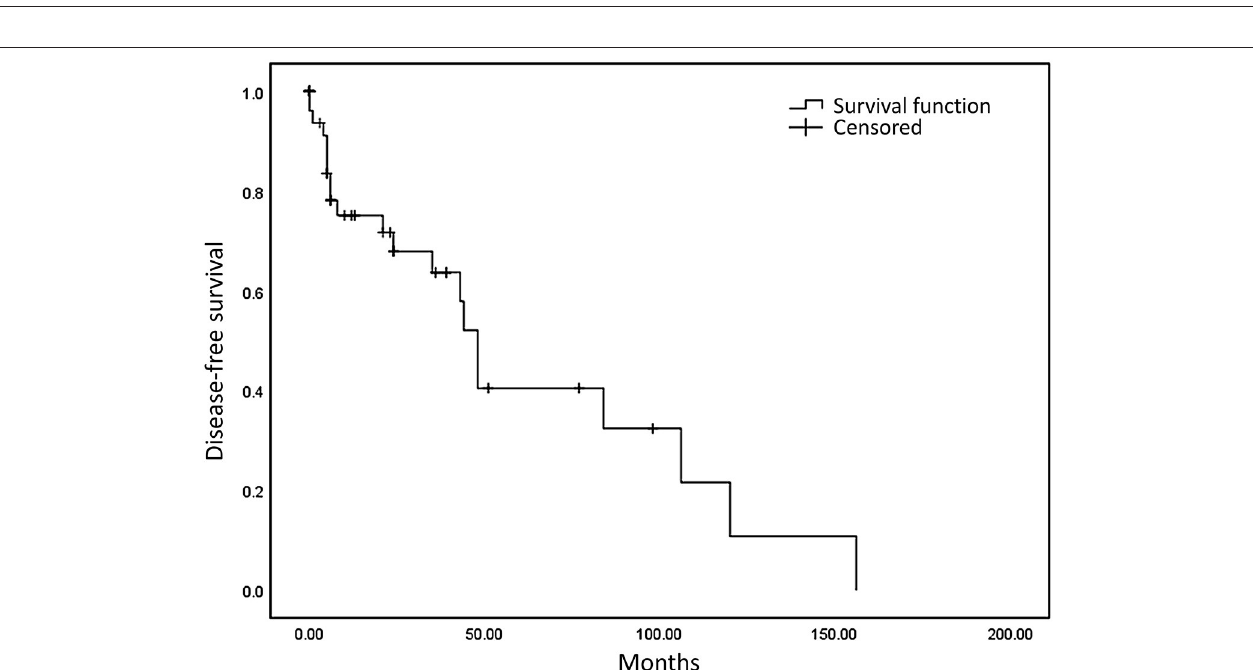
FIGURE 2 | Progression-free survival: the median PFS was 23 months and the 3- and 5-year PFS were 66.2 and 42.3%.